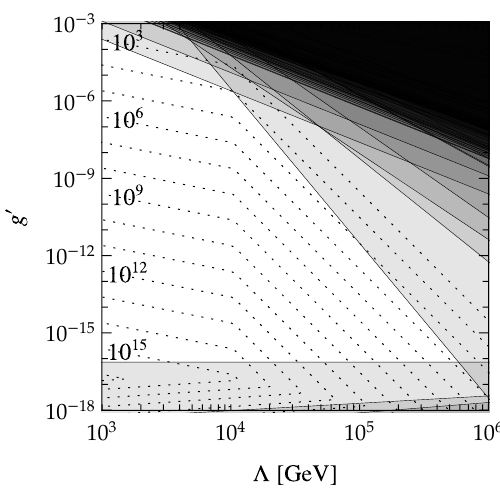
Figure 21 . Same region as in (cid:12)gure 17 (fragmentation during in(cid:13)ation) where we show the contours of the maximum value of the scale f in GeV. The minimal value of f is, in the region of interest, always equal to the cut-o(cid:11) scale (cid:3), as required by the condition in eq. (3.5) on the consistency of the symmetry breaking pattern.